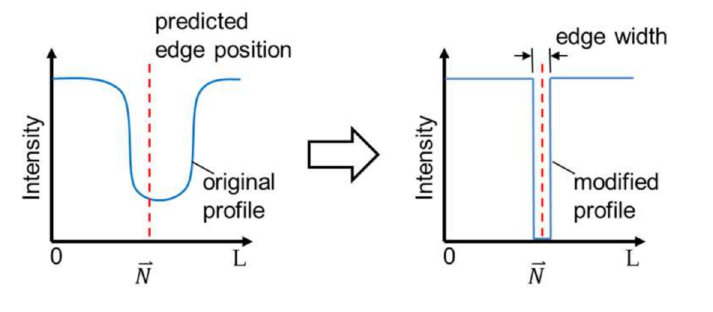
Figure 6. The image modification for sharpening the edge with a predicted edge